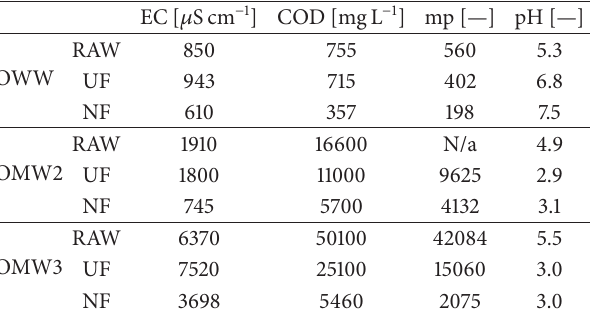
Table 3: Feedstock characteristics.